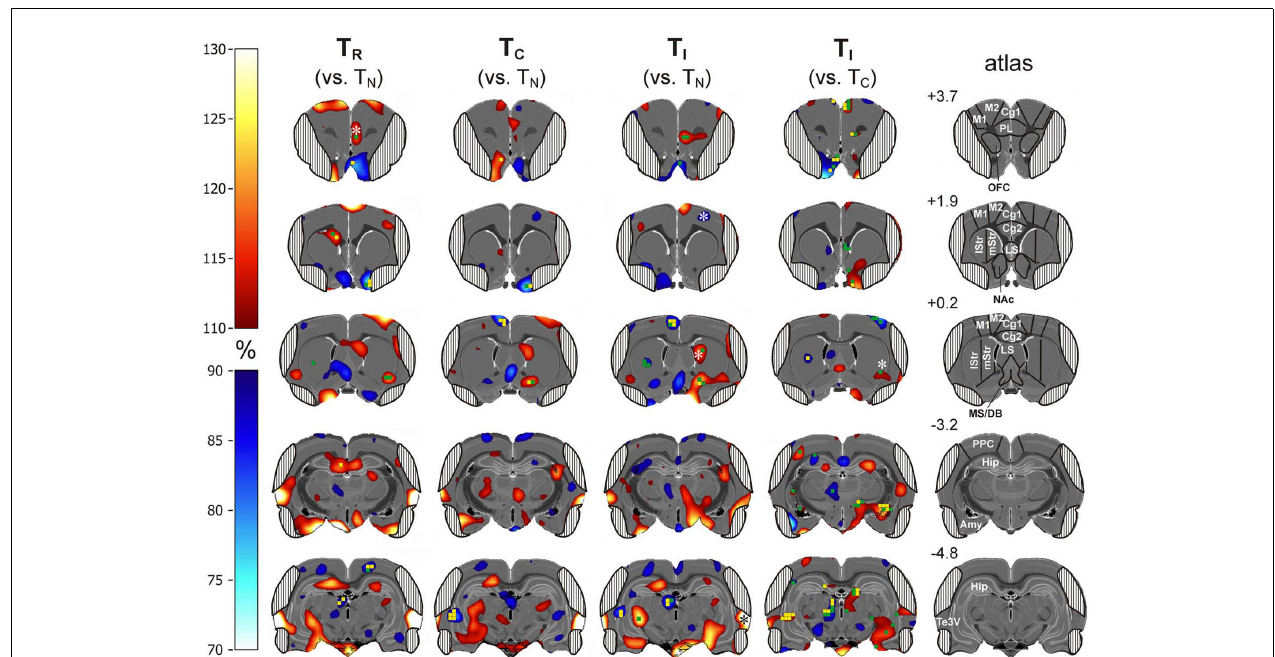
transverse sections of a master brain. Column 5: coordinates (mm from Bregma) and analyzed volumes of interest (VOIs). Areas obscured by muscle artifacts are masked. Significant voxels (uncorrected p < 0.05) are shown in green and (uncorrected p < 0.02) in yellow, significantVOIs are indicated by